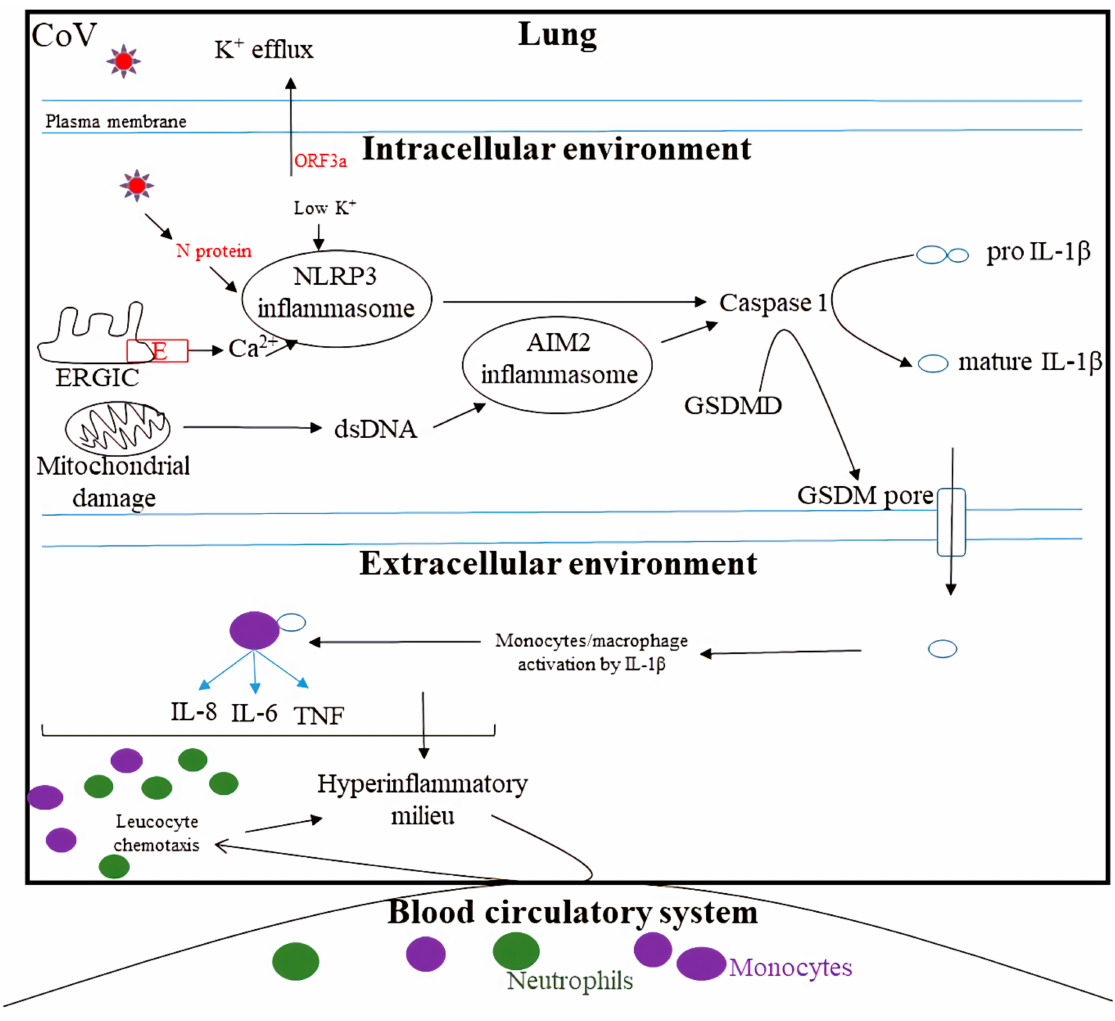
Figure 3. Activation of inflammasome by CoV, leading to hyperinflammation: The viroporins, ORF3a, and E can trigger K + efflux or Ca 2+ influx to induce NLRP3 activation. Moreover, the N protein can bind directly to NLRP3, inducing its activation. Additionally, mitochondrial damage can result in the production of dsDNA, which activates the AIM2 inflammasome. NLRP3 and AIM2 inflammasomes activate caspase 1, which cleaves GSDMD into amino-terminal and carboxy-terminal fragments. The GSDMD amino-terminal fragment targets and inserts itself into cellular membrane lipids, forming pores and rendering the membranes permeable. Caspase 1 cleaves pro-IL-1 β into mature IL-1 β , which is released through the GSDMD pore. IL-1 β can stimulate monocytes to secrete additional proinflammatory cytokines such as IL-6, IL-8, and TNF α , which further upregulate inflammation by recruiting lymphocytes such as